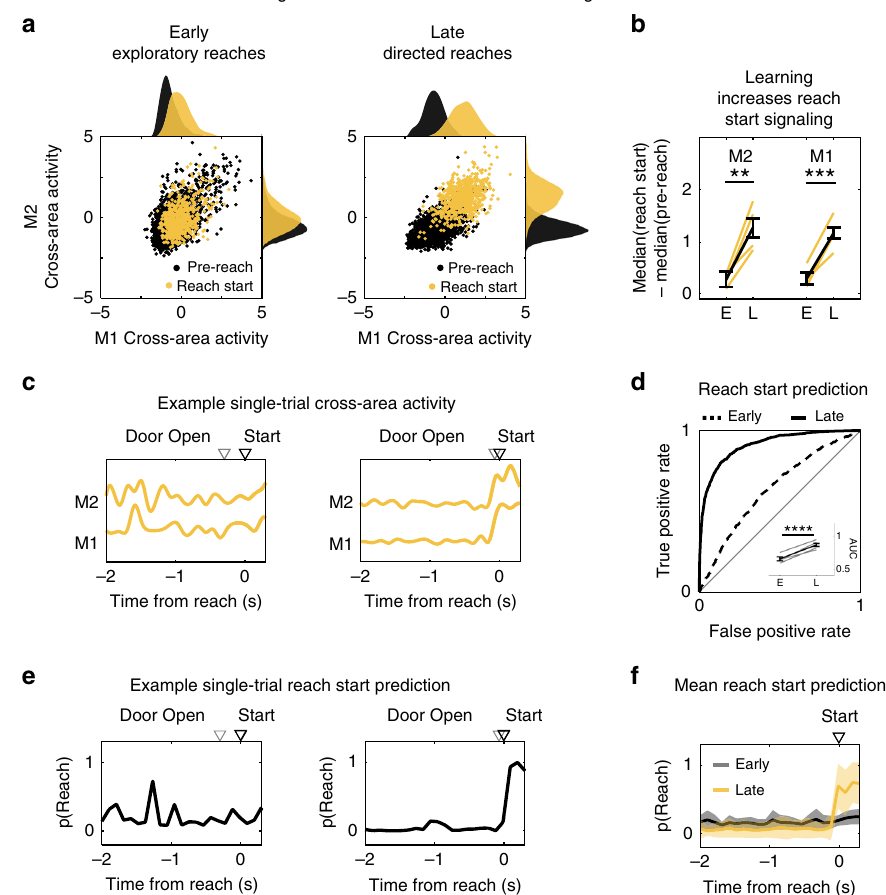
Fig. 4 Learning increases cross-area representation of reach initiation. a M2 – M1 cross-area activity before reach and during reach initiation for example animal, in early (left) and late (right) learning. Probability density functions of M1 (top) and M2 (right). Pre-reach activity in black. Reach start activity in yellow. b Quanti fi cation of ( a ) as the difference between pre-reach and reach median activity during early and late learning for M2 ( p = 0.0017) (left) and M1 ( p = 0.00053) (right) cross-area activity. Yellow lines show values for individual animals, black line shows mean ± SEM, n = 4 rats. ** p < 0.01; *** p < 0.0001; two-sided t -statistics, not adjusted for multiple comparisons. c Example single-trial M2 and M1 cross-area activity before and during reach initiation. (Left) Early learning. (Right) Late learning. Time to reach initiation is indicated by triangles marking door opening (gray open triangle) and reach start (black open triangle). d ROC analysis of detection of reach initiation from M2 and M1 cross-area activity using logistic regression (example animal). (Inset) Difference in reach detection with learning quanti fi ed as the area under the curve (AUC) for all animals ( p = 6.63 × 10 − 5 ). Gray lines show values for individual animals, black lines show mean ± SEM, n = 4 rats. **** p < 0.0001. two-sided t -statistic, not adjusted for multiple comparisons. e Example single-trial prediction of reach initiation using the models built in d , same trials as c . (Left) Early learning. (Right) Late learning. f Comparison of mean prediction of reach initiation during early (gray) and late (yellow) learning for example animal. Shaded region shows SEM, n = 4